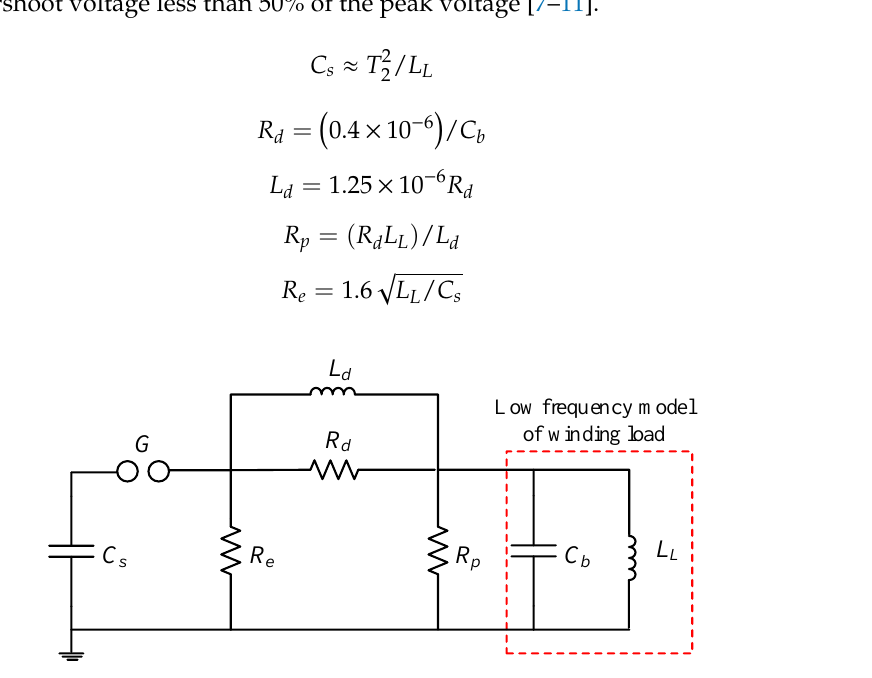
Figure 3. Glaninger’s generator circuit for the lightning impulse voltage tests on the winding. However, the distortion in the waveform generated by the circuit with parameters from K.